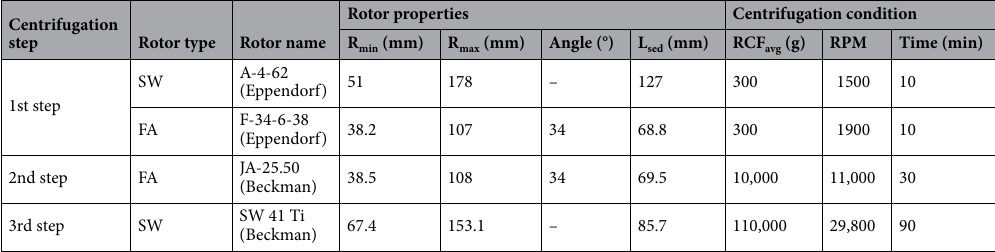
Table 1. Centrifugation and rotor information for MV and exosome